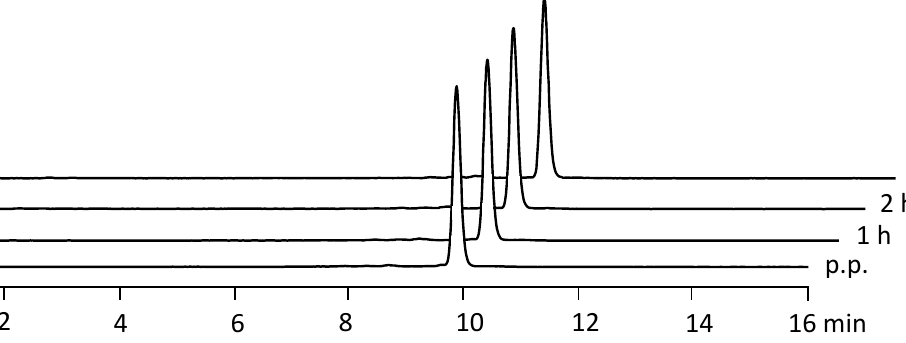
Figure 3. Radio-HPLC analysis of 68 Ga-DOTA-MGS5 post preparation (p.p.) and at 1, 2, and 3 h EOS. Table 2. Stability testing of 68 Ga-DOTA-MGS5 up to 3 h after preparation. Stability Testing